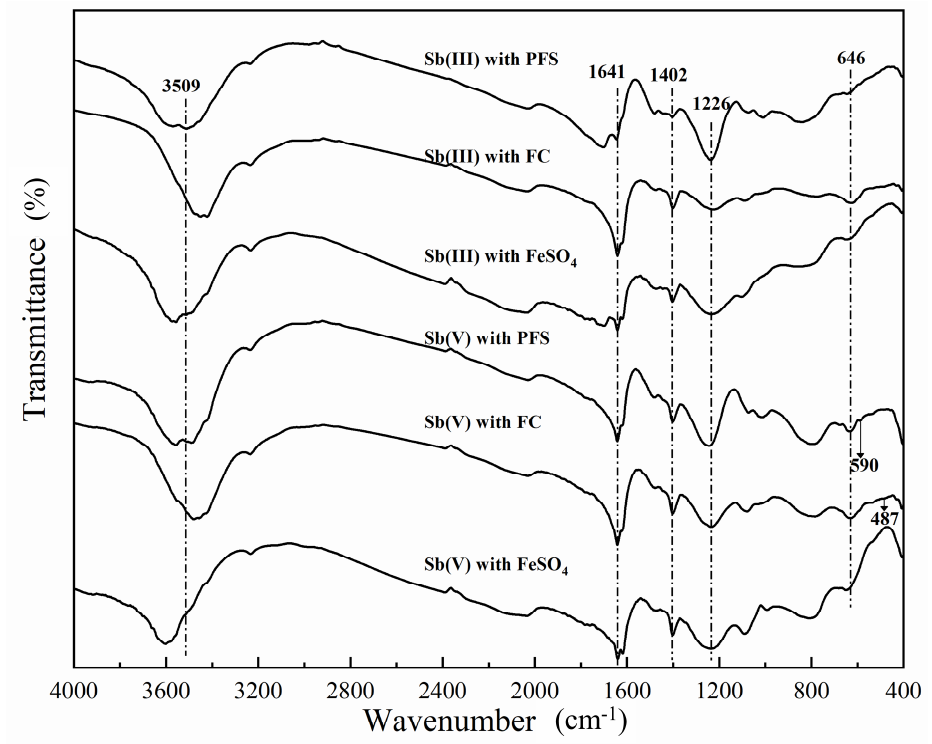
Figure 6. FTIR spectra for the precipitates of PFS, FC, and FeSO 4 after reaction with Sb(III) and Sb(V).